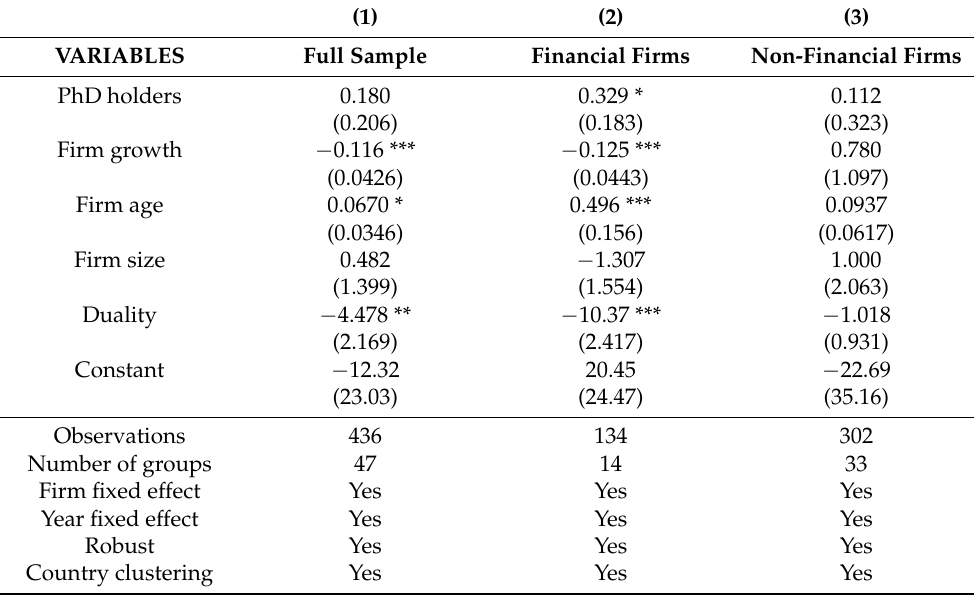
Table 4. Gender Diversity determinants at the Palestinian listed